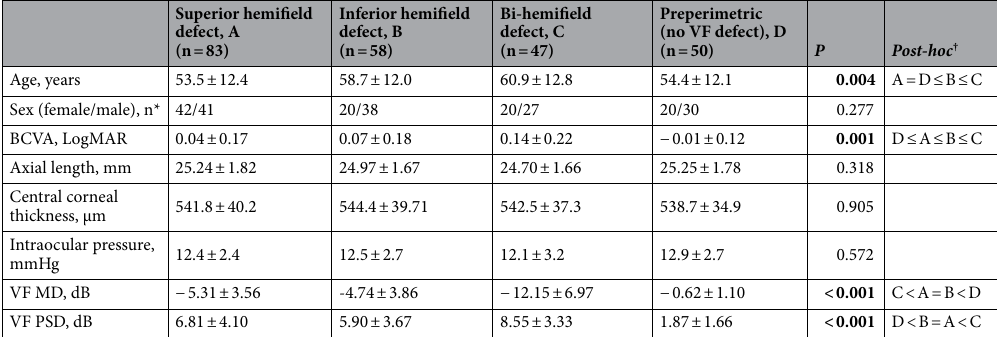
Table 2. Comparison of the clinical characteristics in the POAG eyes with visual field defects in various hemifields. *Comparison was performed using Chi-square test. Other comparisons were performed using one-way analysis of variance. † Tukey-b’s post-hoc test. Significant values are shown in bold. POAG = primary open-angle glaucoma; BCVA = best-corrected visual acuity; LogMAR = Logarithm of the Minimum Angle of Resolution; VF = visual field; MD = mean deviation; PSD = pattern standard deviation.